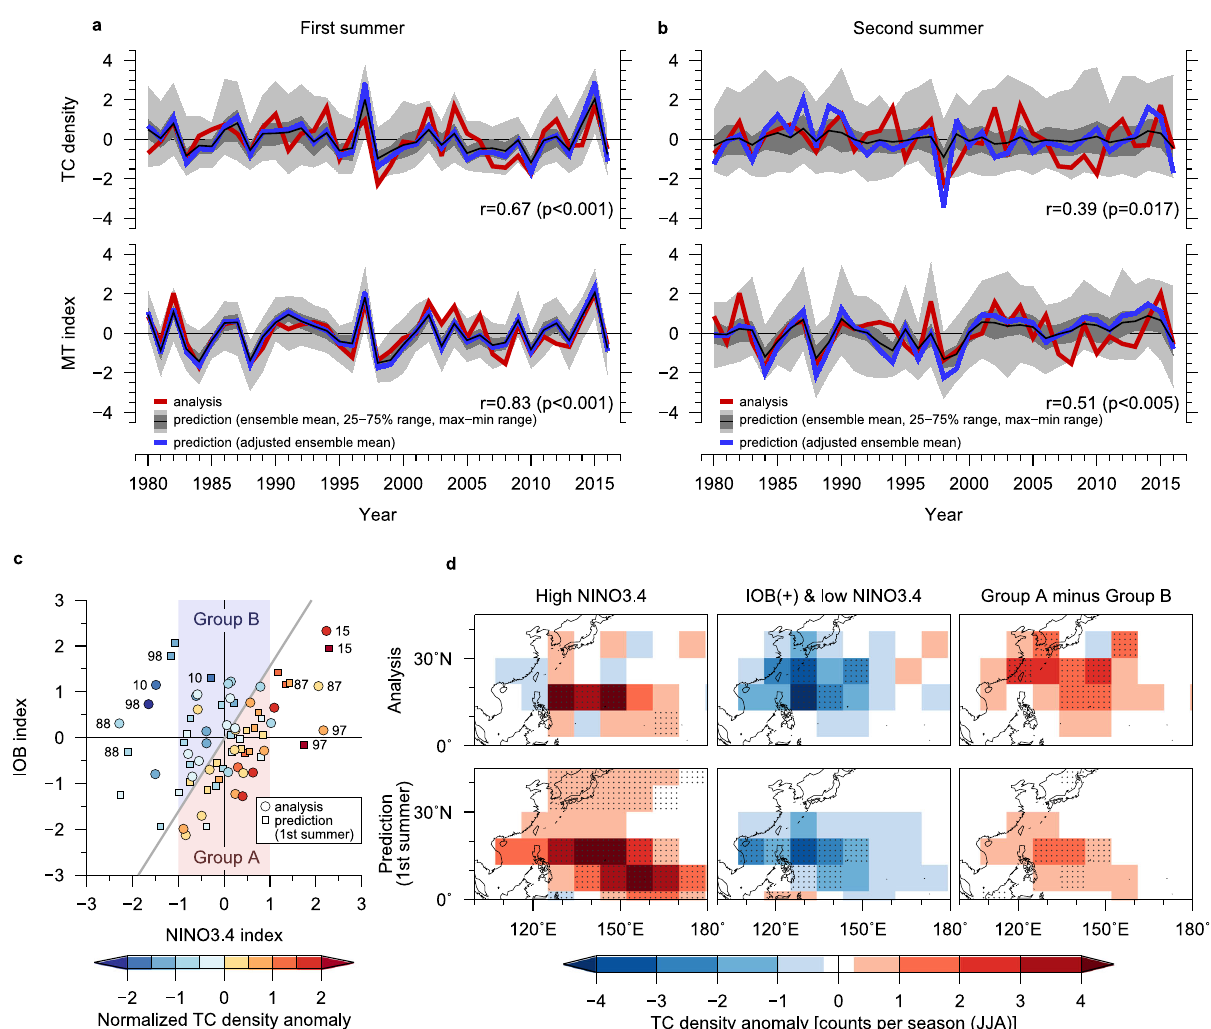
Fig. 5 TC prediction skill and in fl uence from ENSO and IOB SST. Same as Fig. 1 but for the a fi rst and b second summer predictions of the tropical cyclone (TC) density and monsoon trough (MT) index. c Scatterplot of the analysed (circles) and predicted (squares) TC densities with respect to their own Indian Ocean Basin (IOB) and NINO3.4 SST indices. Colours indicate the TC density accumulated in the western North Paci fi c (WNP) region normalised by the climatological mean and standard deviation. Two-digit numbers shown alongside circles or squares indicate years. d Composites of observed and predicted TC density anomalies for summers with (left) the NINO3.4 index > + 1.5 std. dev., (middle) the IOB index >0 and NINO3.4 index < − 1 std. dev., and (right) Group A minus Group B (groups shown in Fig. 5c). Stippled regions are statistically signi fi cant at the 5% level according to a bootstrap